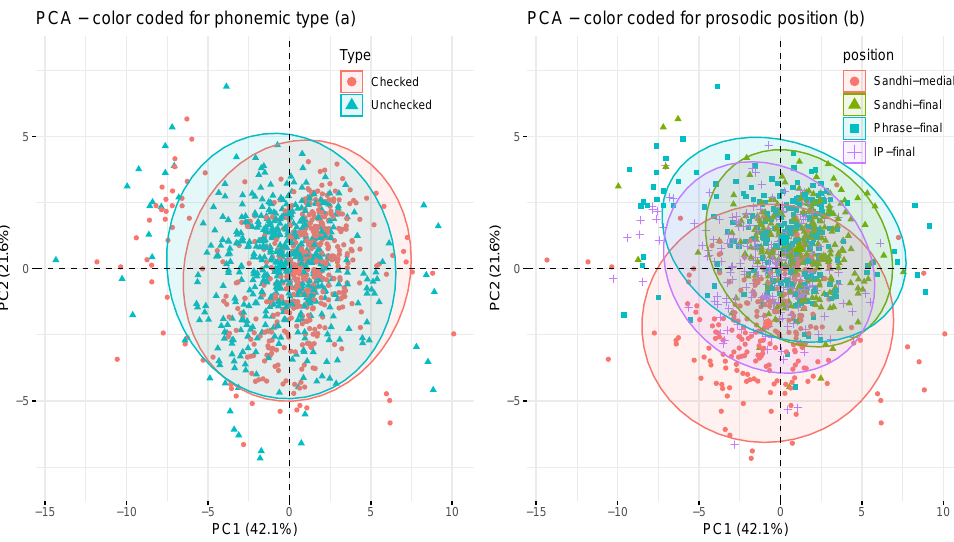
Figure 2. Principal Component Analysis of the acoustic space. ( a ) Color‑coded for targets’ phonemic type. ( b ) Color‑coded for targets’ prosodic position. Concentration ellipse level =